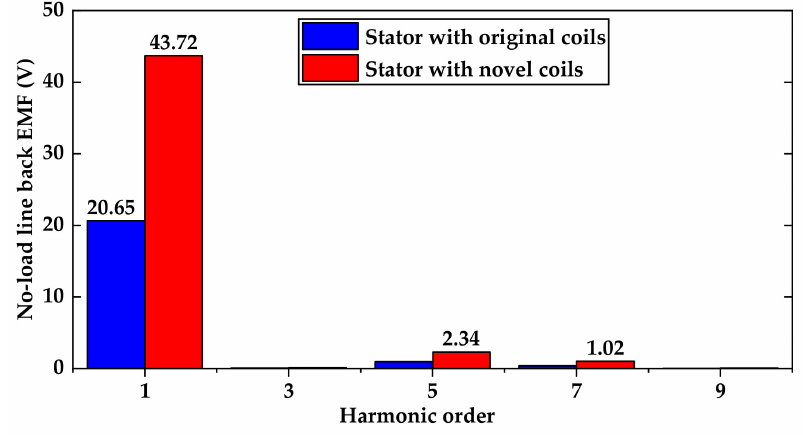
Figure 8. Harmonic decomposition results of the no-load line back EMF.